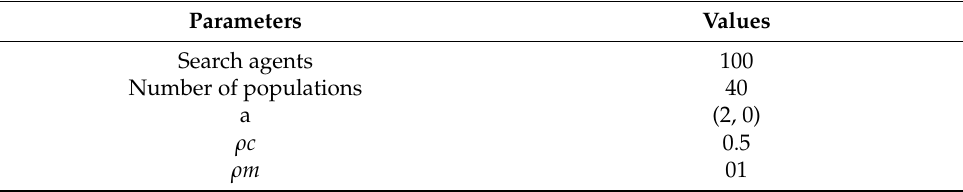
Table 1. Parameter settings of